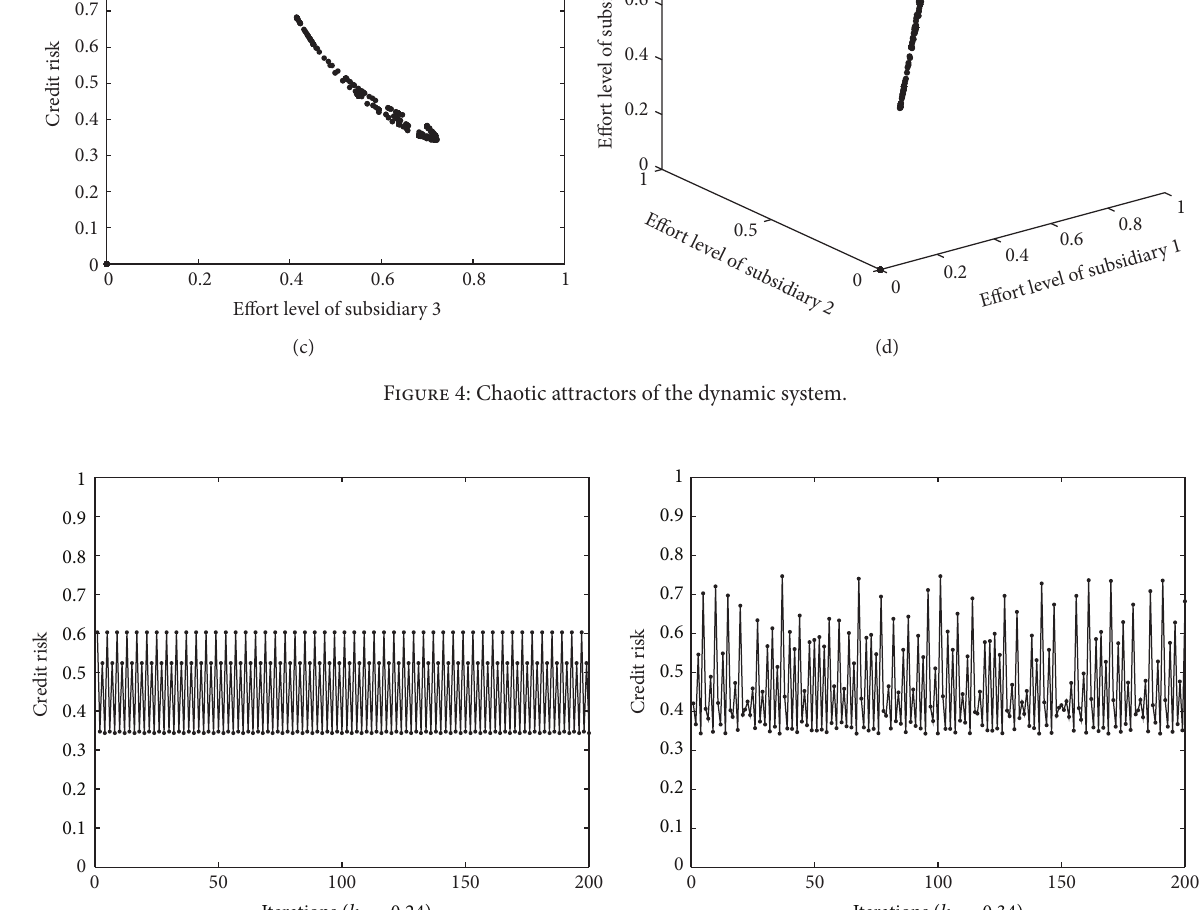
Figure 5: Sequence diagram showing the changes in the credit risk of the business